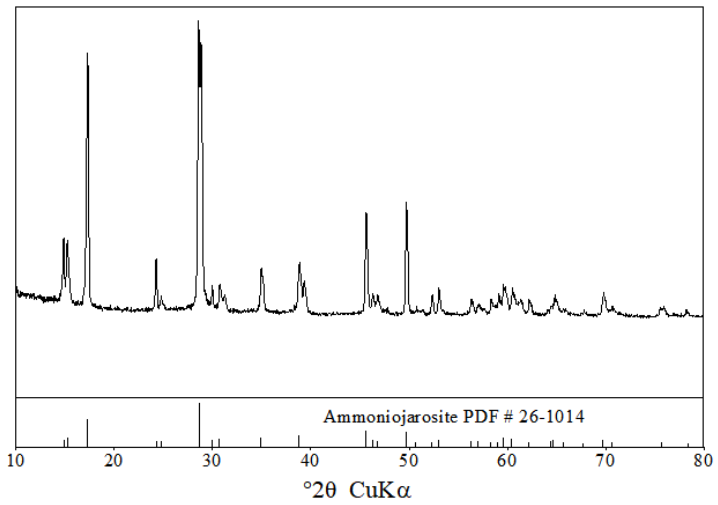
Figure 2. XRD patterns of precipitates.